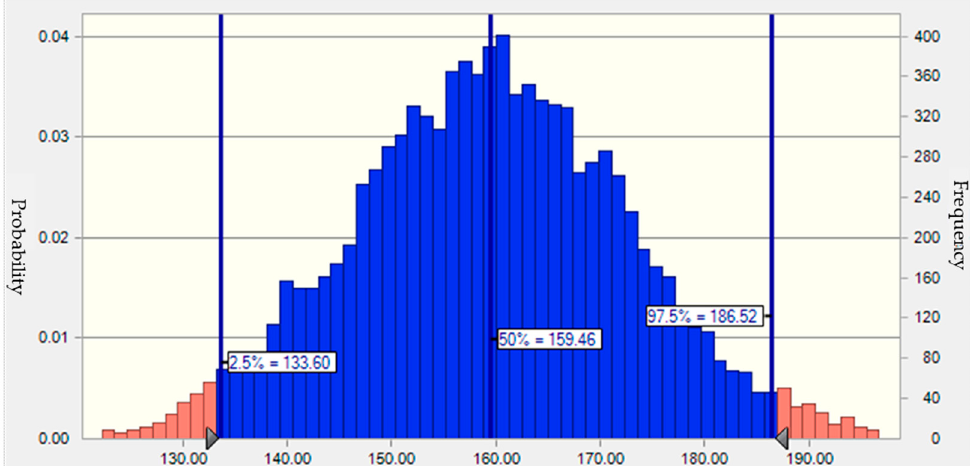
Figure 9. Corporate tax probability distribution (triangular distribution).